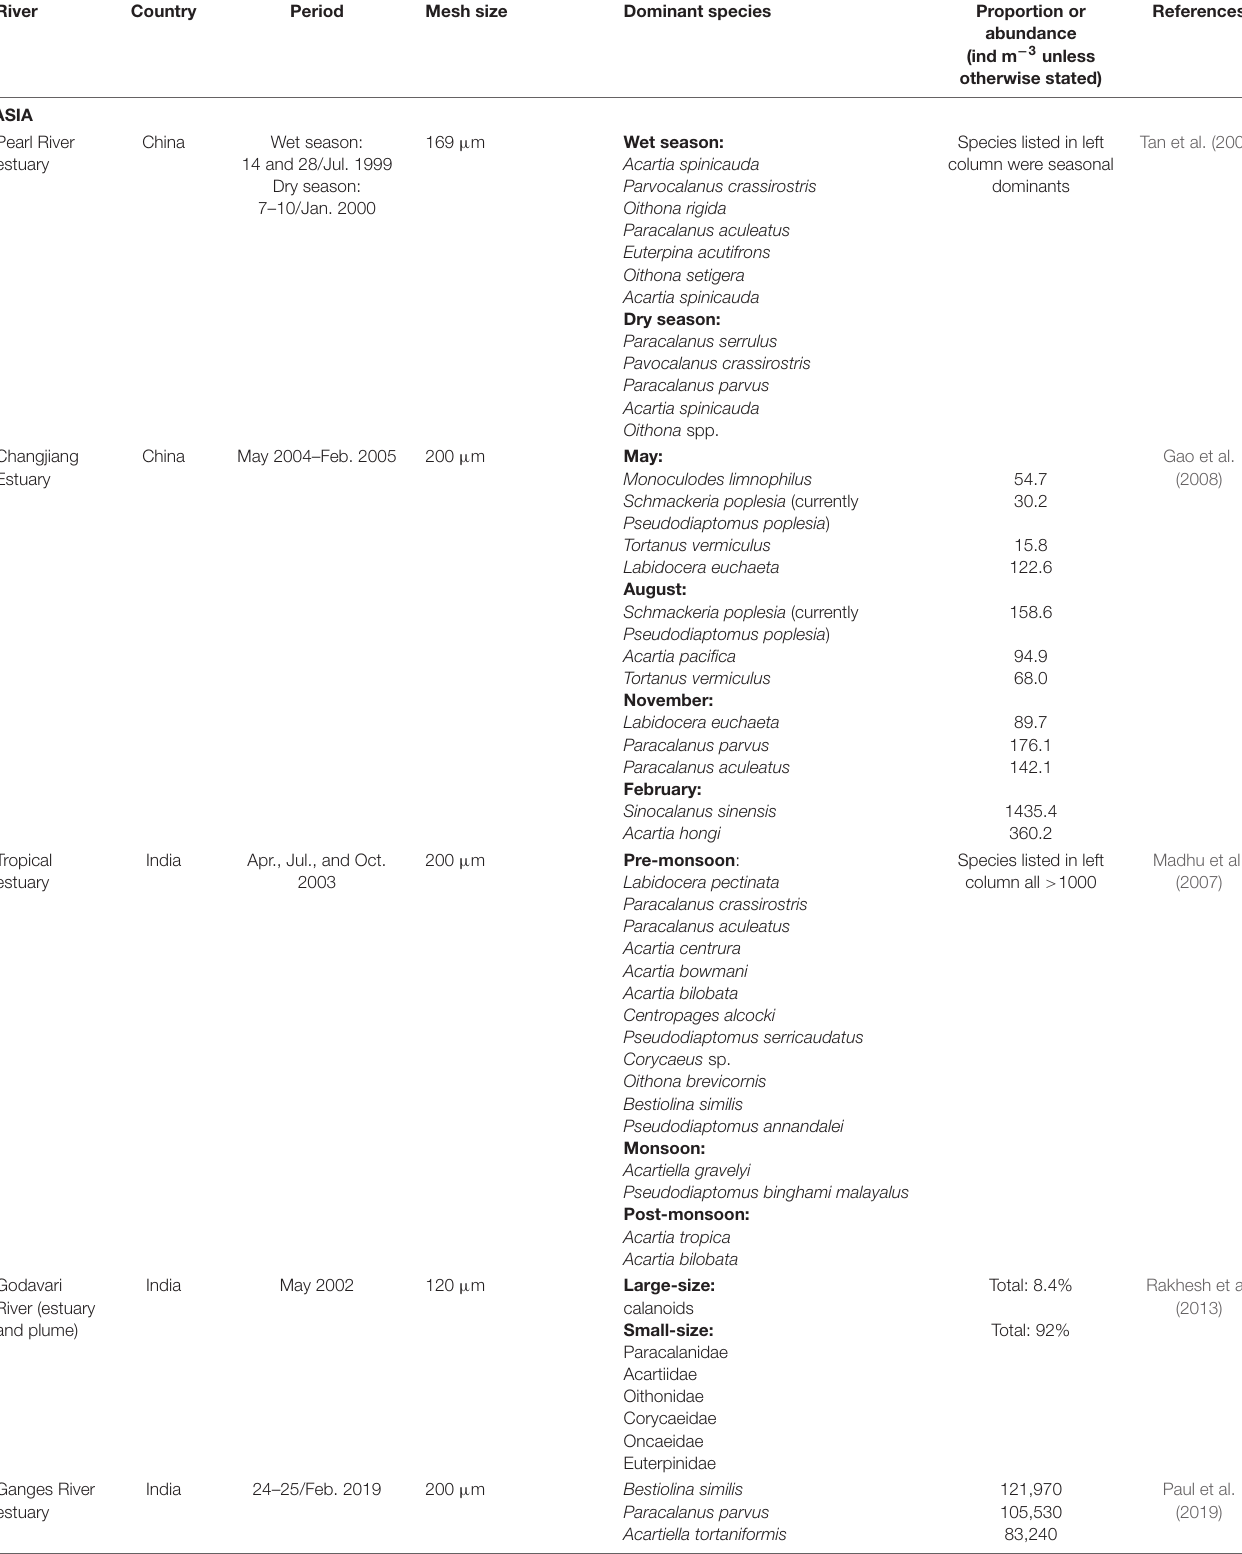
TABLE 5 | List of the dominant copepods recorded from the downstream reaches and estuaries of rivers around the world. River